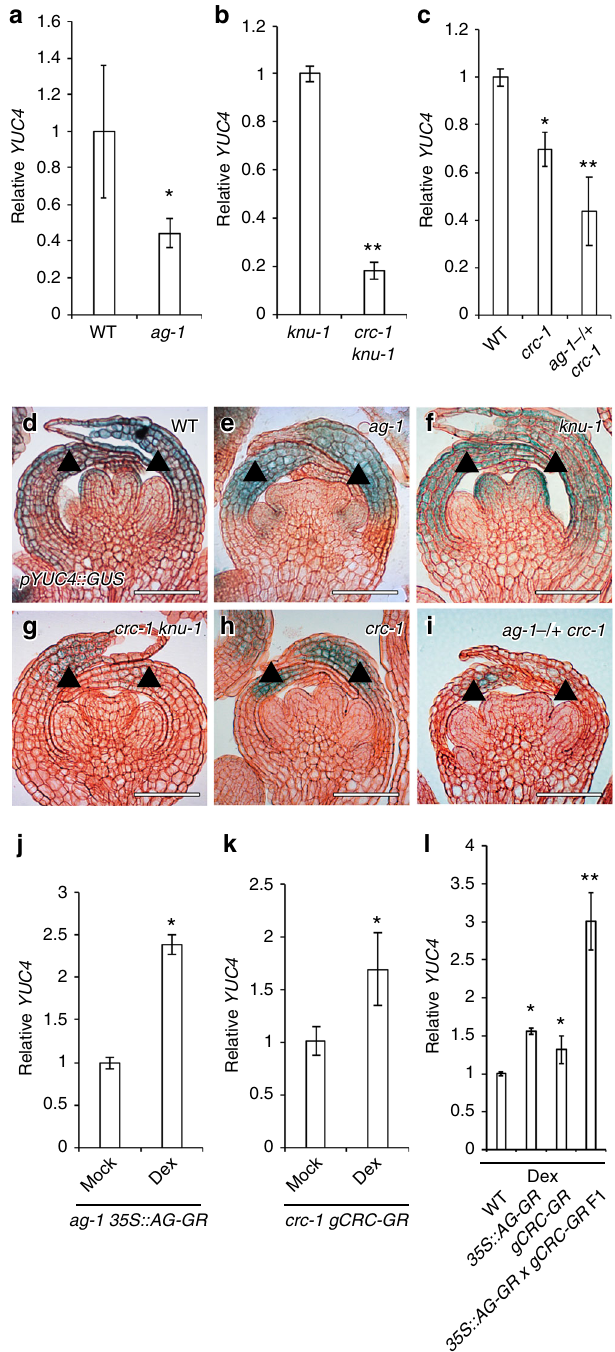
Fig. 2 AG and CRC synergistically control YUC4 expression. a – c YUC4 mRNA levels in wild-type and ag-1 ( a ), knu-1 and crc-1 knu-1 ( b ), wild-type, crc-1 , and ag-1-/ + crc-1 ( c ) fl oral buds. The values are represented as the means±SEMs. p -values were calculated with a two-tailed Student ’ s t -test. * p < 0.05 compared to wild type. ** p < 0.05 compared to single